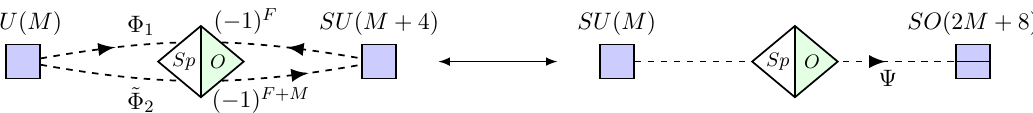
CFT. In the right-hand SO